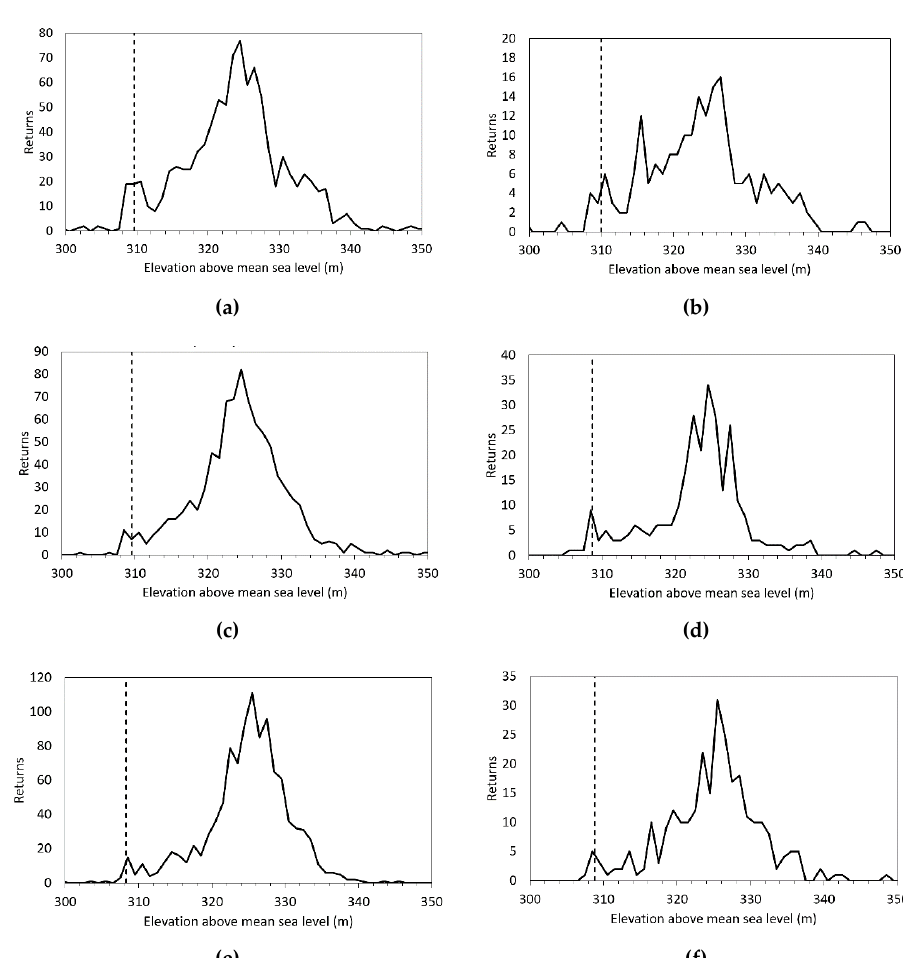
Figure 7. ICESat-2 ATLAS return histograms for each spot, inferred ground elevation indicated by a dashed line. ( a ) GT1L (strong), ( b ) GT1R (weak), ( c ) GT2L (strong), ( d ) GT2R (weak), ( e ) GT3L (strong), ( f ) GT3R (weak). Abscissa scales varied for legibility.